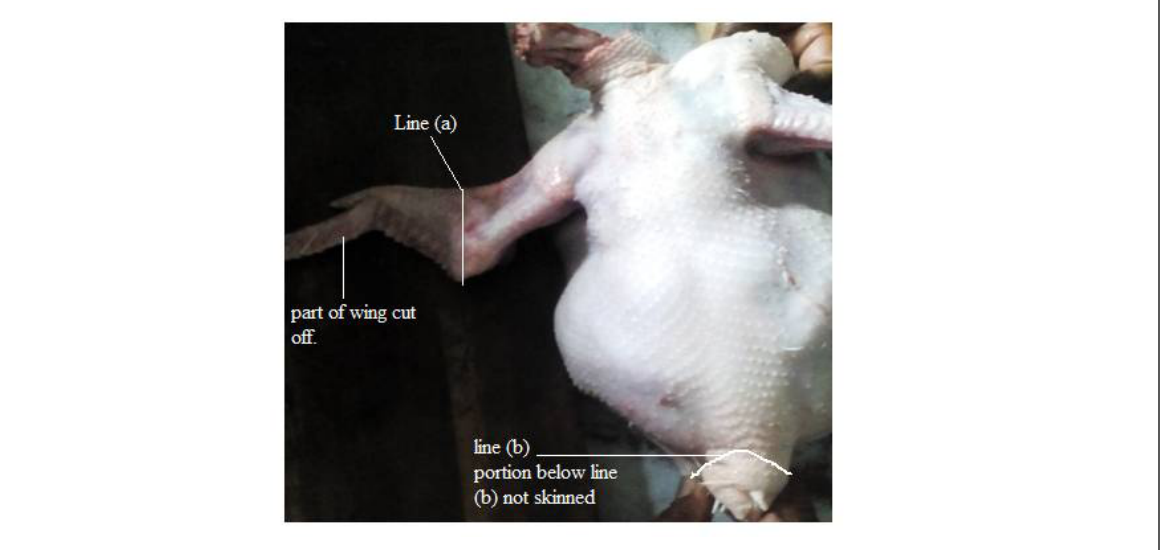
Figure 3: Line (a) along which wings were cut off. Portion below line (b) not included in the